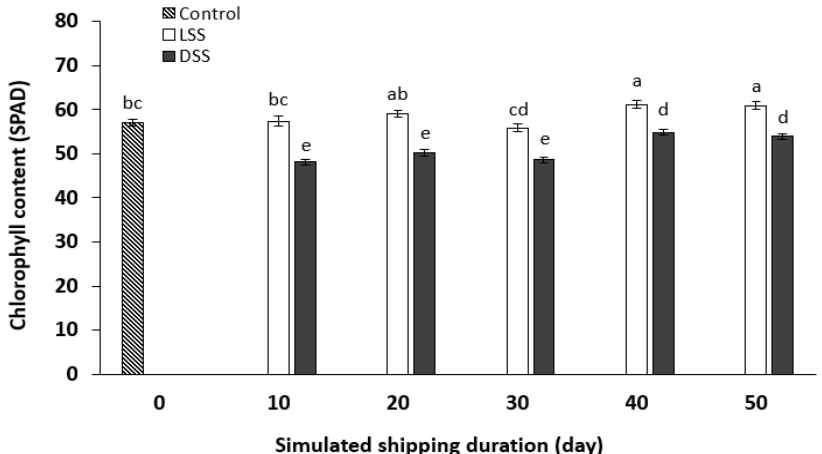
Figure 4. Chlorophyll content (SPAD) at the end of each simulated shipping as influenced by simulated shipping duration in Phalaenopsis Sogo Yukidian ‘V3’. Within-graph means followed by the same letter are not significantly different according to Duncan’s multiple range test at p ≤ 0.05.